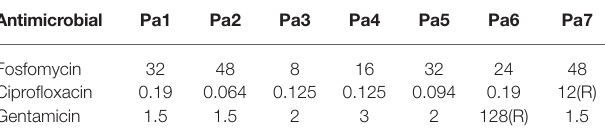
TABLE 4 | MIC of P. aeruginosa by Etest. Antimicrobial